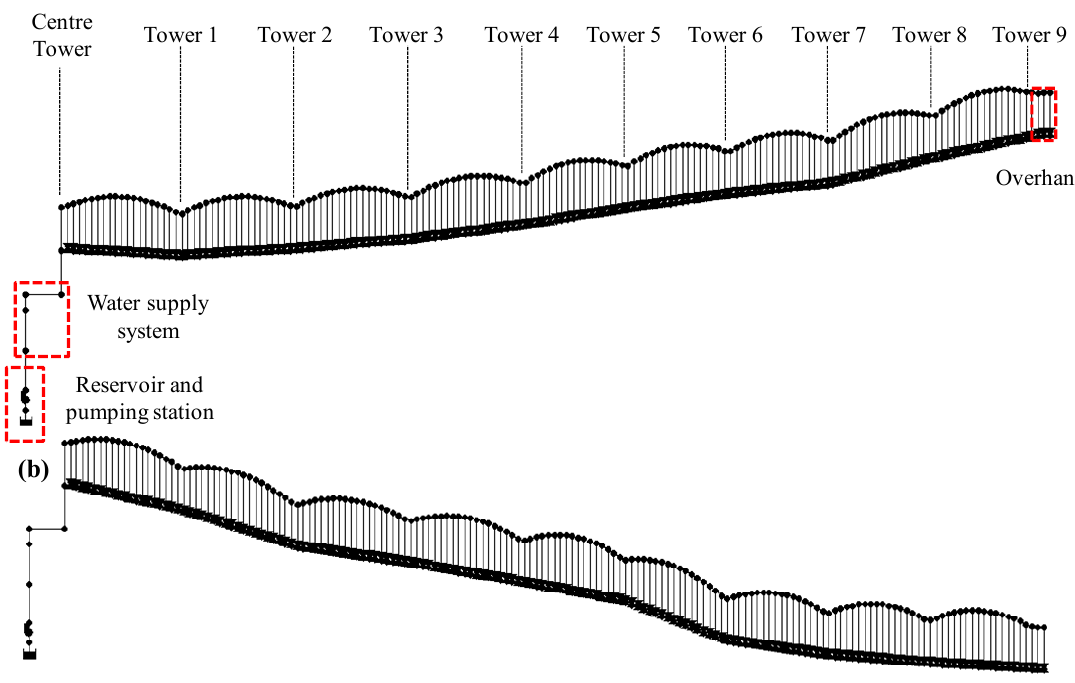
Figure 4. Network maps of the center pivot system from EPANET inp files generated by the VSPM (Variable Speed Pivot Model) tool considering two different lateral line angular positions ( a ) 250° uphill and ( b ) 40° downhill.